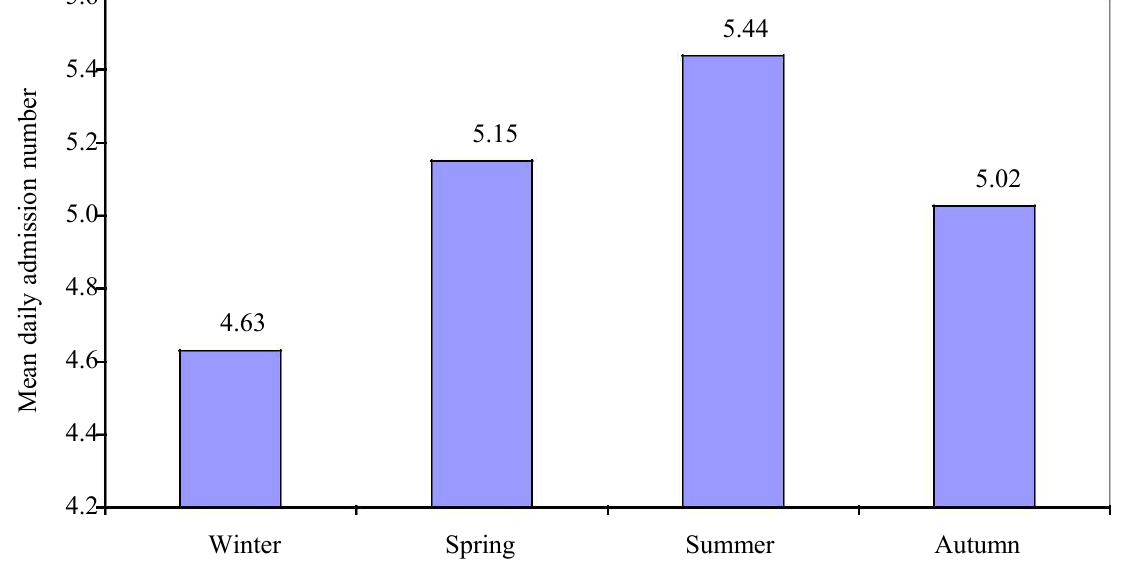
Figure 1. Seasonal patterns of admissions of schizophrenic patients in